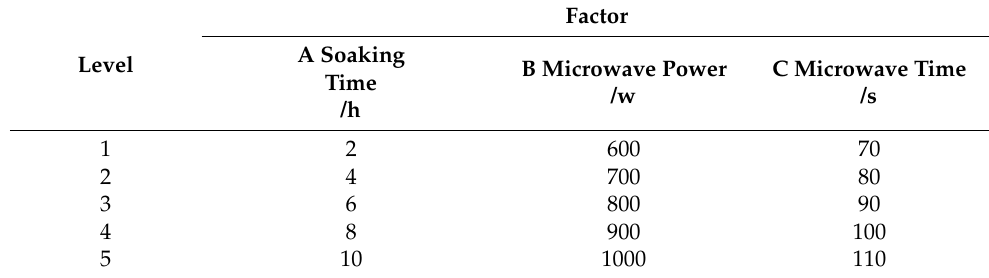
Table 1. Single-factor experiments analysis.